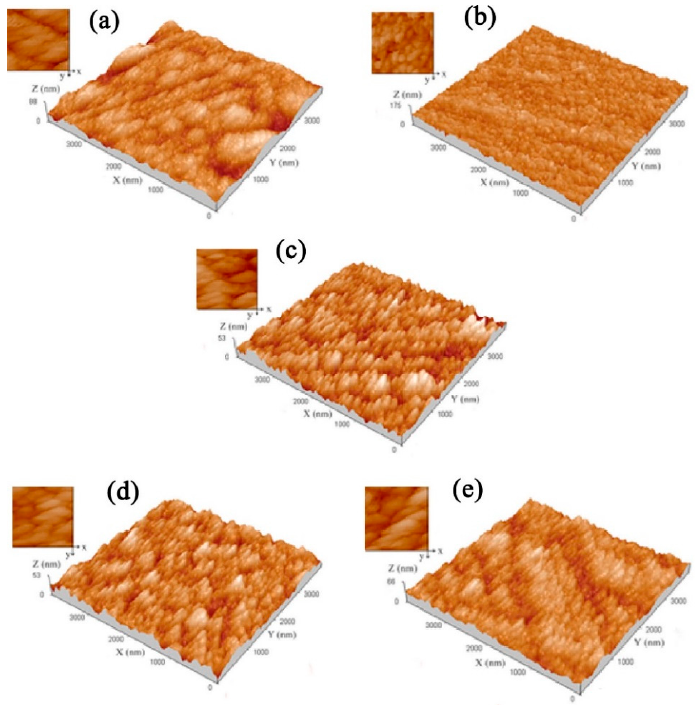
Figure 4. AFM patterns of the InN thin films deposited at ( a ) 200 °C, ( b ) 300 °C, ( c ) 400 °C, ( d ) 500 °C and ( e ) 600 °C.